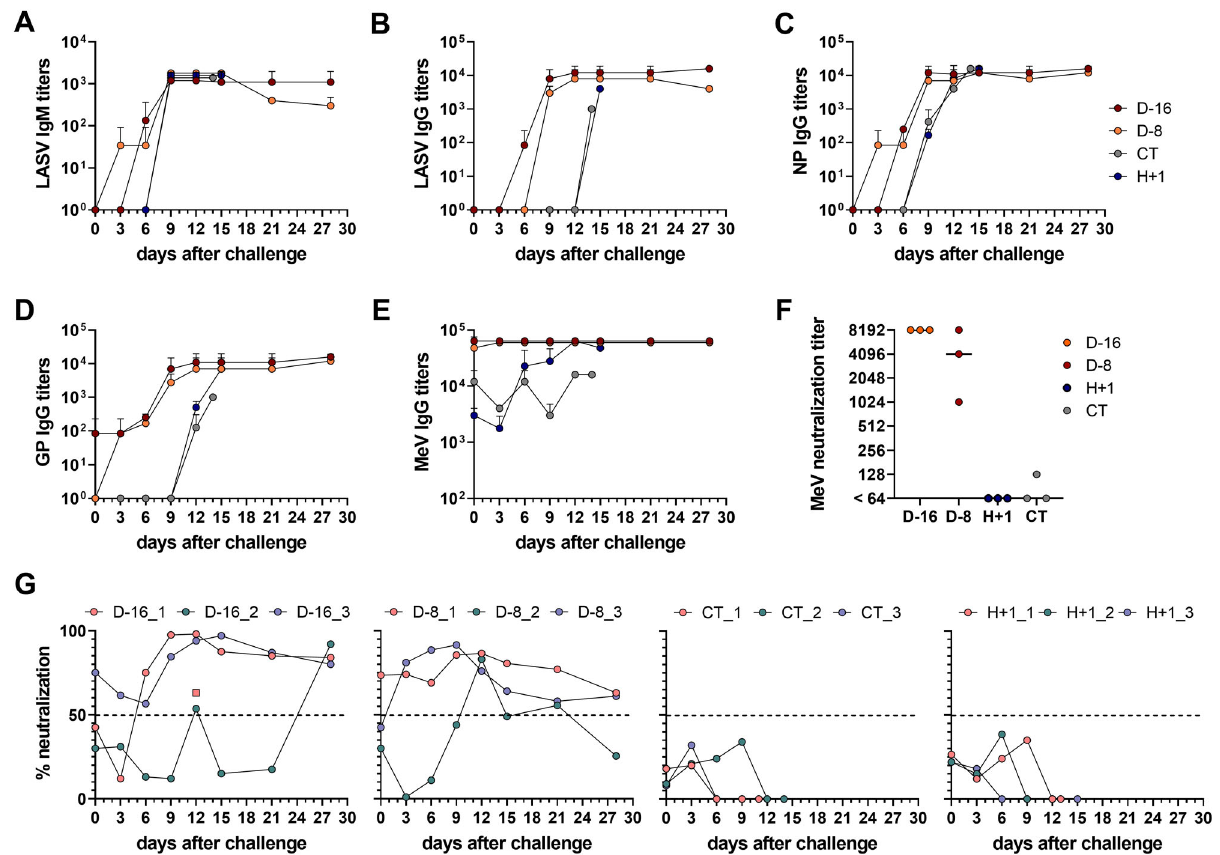
Fig. 4 | Antibody responses inducedafter LASV challenge. Detection of A LASV- speci fi c IgM, B LASV-speci fi c IgG, C NP-speci fi c IgG, D GP-speci fi c IgG, and E Measles-speci fi c IgG in animals after the LASV infection by ELISA. Each point represents the mean±SEM of three samples, except for the CT animals on day 12 (2samples) andday 14(one sample).Forstatisticalpurposes, the sampleof animal CT_2collectedatthetime ofdeathonday11isrepresentedasbeing onday12,and the sampleofanimalH+1_1 collected atthe timeofdeath onday13isrepresented asbeing onday15.AKruskal – Wallistestwasused aftertesting fornormalitywitha Shapiro-Wilknormalitytest. F Measlesvirusneutralizingantibodytiters,expressed